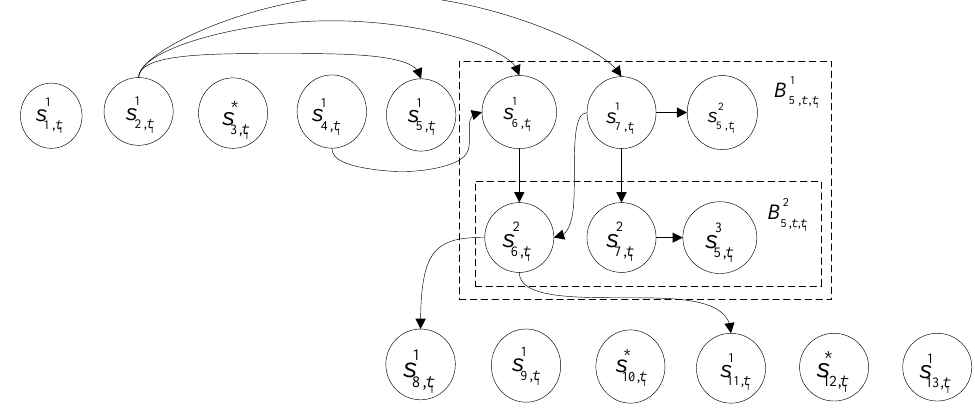
Figure 1. The execution impact graph G 1 formed when Program 1 is executed by test case